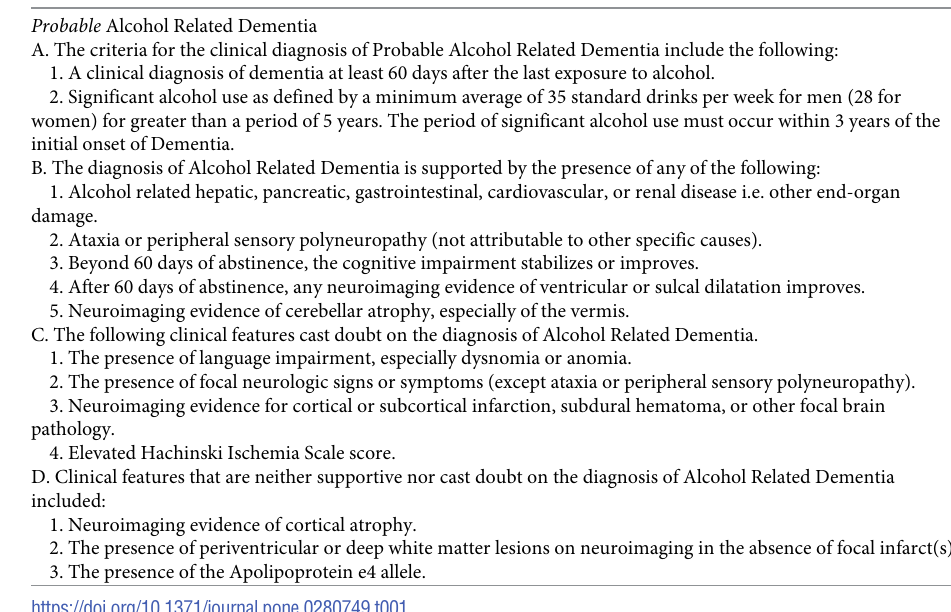
Table 1. Classification of ‘probable’ ARD (reproduced from [13]). Probable Alcohol Related Dementia A. The criteria for the clinical diagnosis of Probable Alcohol Related Dementia include the following: 1. A clinical diagnosis of dementia at least 60 days after the last exposure to alcohol. 2. Significant alcohol use as defined by a minimum average of 35 standard drinks per week for men (28 for women) for greater than a period of 5 years. The period of significant alcohol use must occur within 3 years of the initial onset of